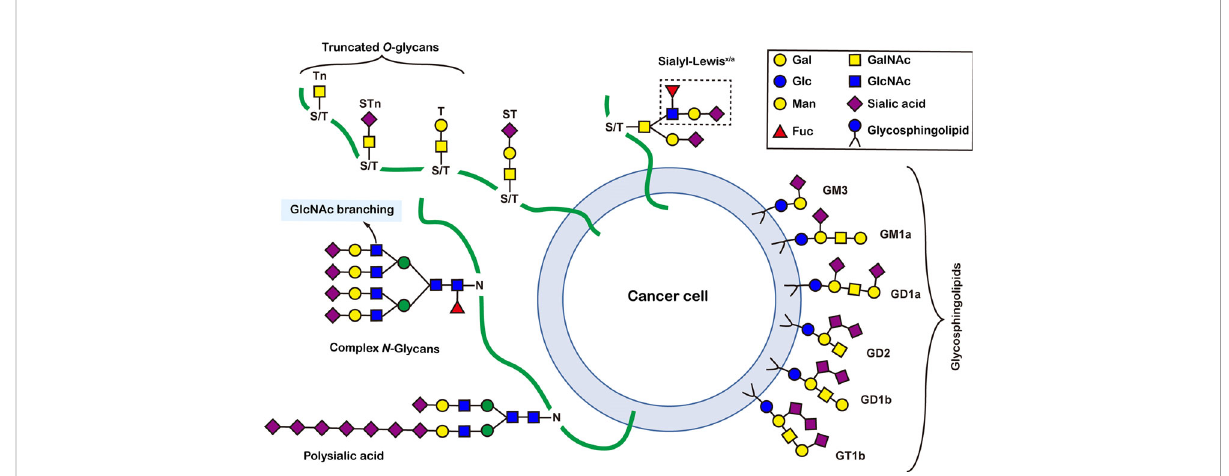
FIGURE 1 Common glycoconjugates in mammalian cells. N -glycans have a pentasaccharide core or a trimannosyl core, and the ends are further modi fi ed by GlcNAc, Gal, and SIa. O -glycans contain 6 main basic core structures and are further extended to generate structures of various core and different terminal glycans. Glycosphingolipids are composed of ceramides and a series of variable glycans.